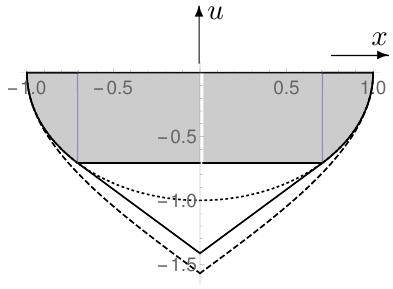
Figure 1. Approximate solutions for the QR, discussed from the bottom up. 1. dashed curve: u = arccos x , 2. full curve: solution (13) continued by straight lines, 3. dotted curve: semicircle, 4. curve with gray filling: HH-like